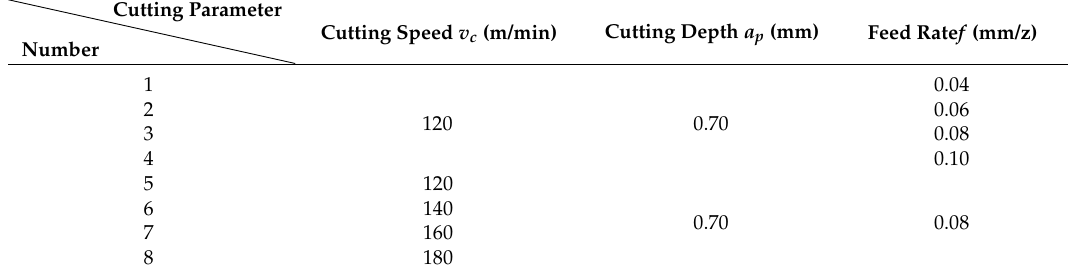
Table 1. Single factor experiment for cutting titanium alloy.